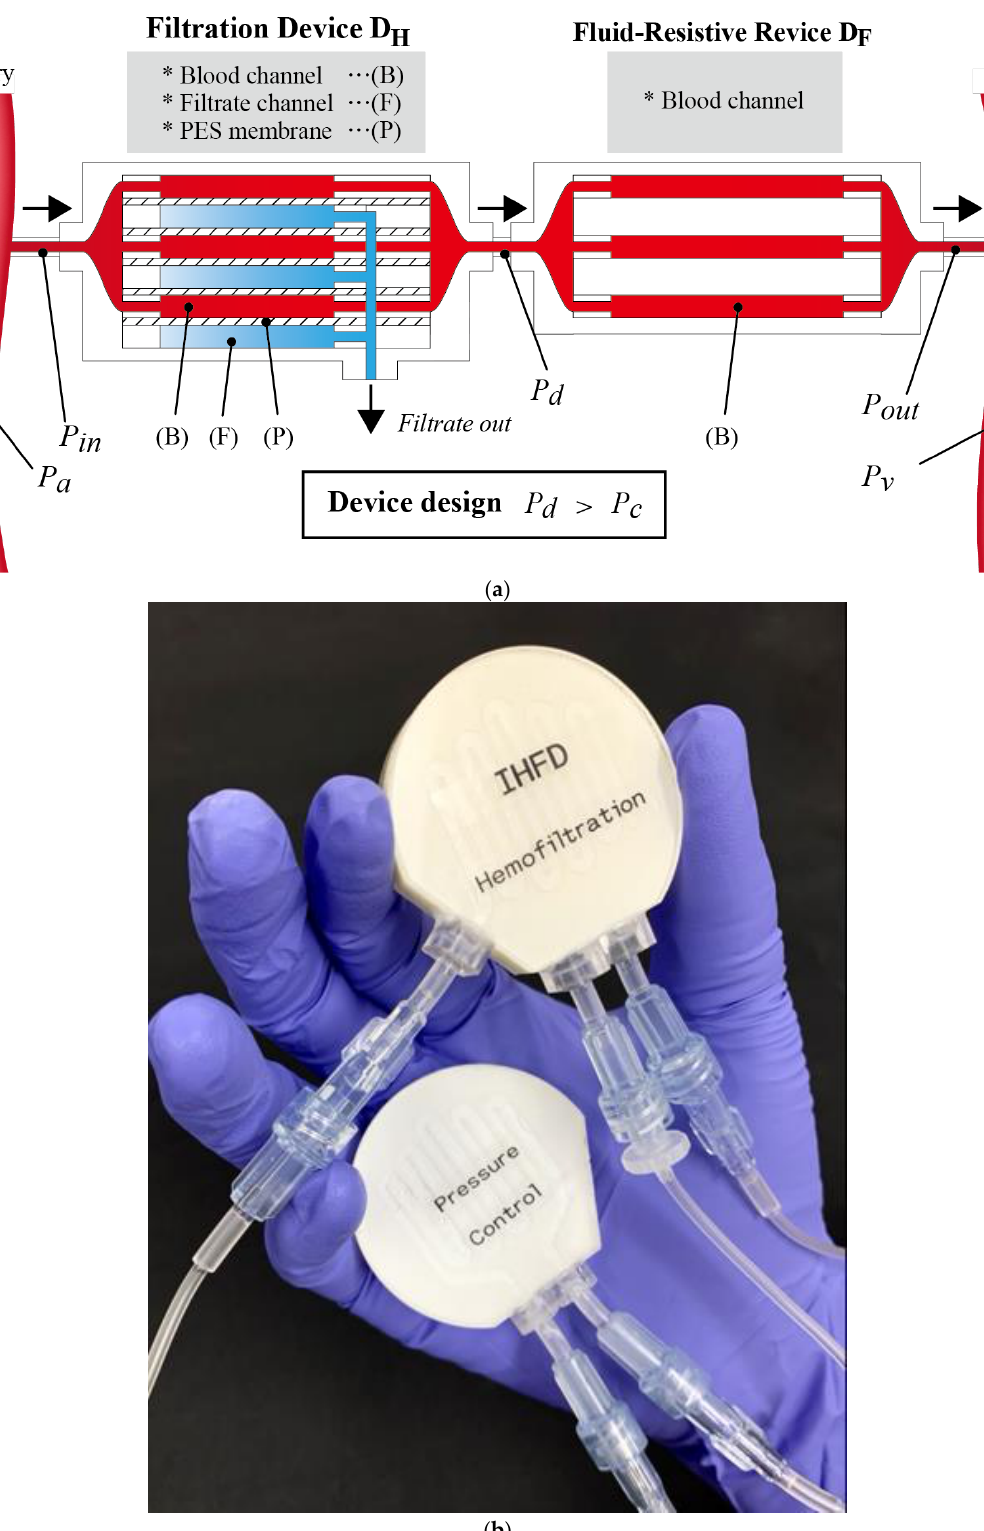
Figure 3. ( a ) Serial connection of hemofiltration device D H and fluid-resistive device D F . In this figure, the number of layers for saline (or blood) channels 𝑁 𝐷 and 𝑁 𝐷 are both 3. When D H and D F are designed such that the pressure between 𝐻 𝐹 devices 𝑃 𝑑 exceeds the oncotic pressure 𝑃 𝑐 , no backfiltration takes place. ( b ) Photograph of the serially connected hemo- filtration device D H (“ h emofiltration”) and fluid -resistive device D F (“ pressure contro l”).